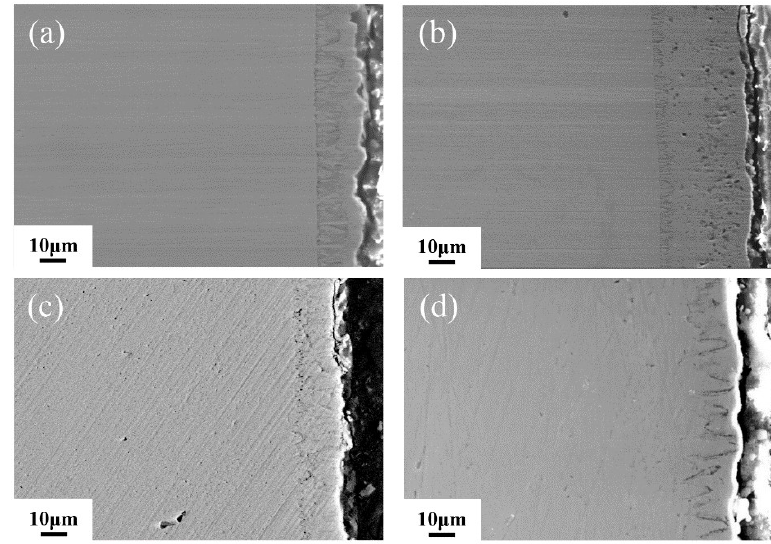
Figure 8. The cross-sectional SEM images of Fe-Al-Cr alloyed layers under different electrode distances: ( a ) 10 mm; ( b ) 15 mm; ( c ) 20 mm; ( d ) 25 mm.